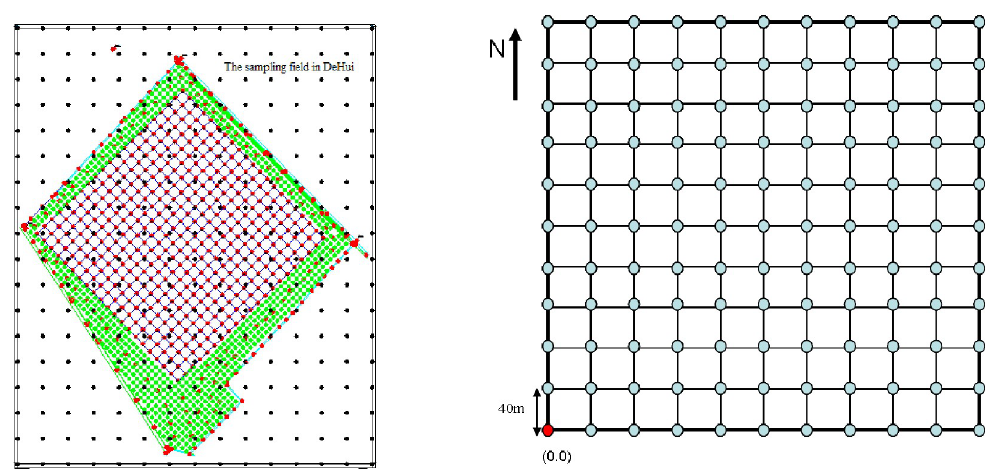
Fig 2. Dimensions of sampling field. On the left is the actual distribution of farmland. The grid area in the right map shows monitoring plots with 40 m intervals, and the point (0, 0) is the coordinate origin of the monitoring graph.